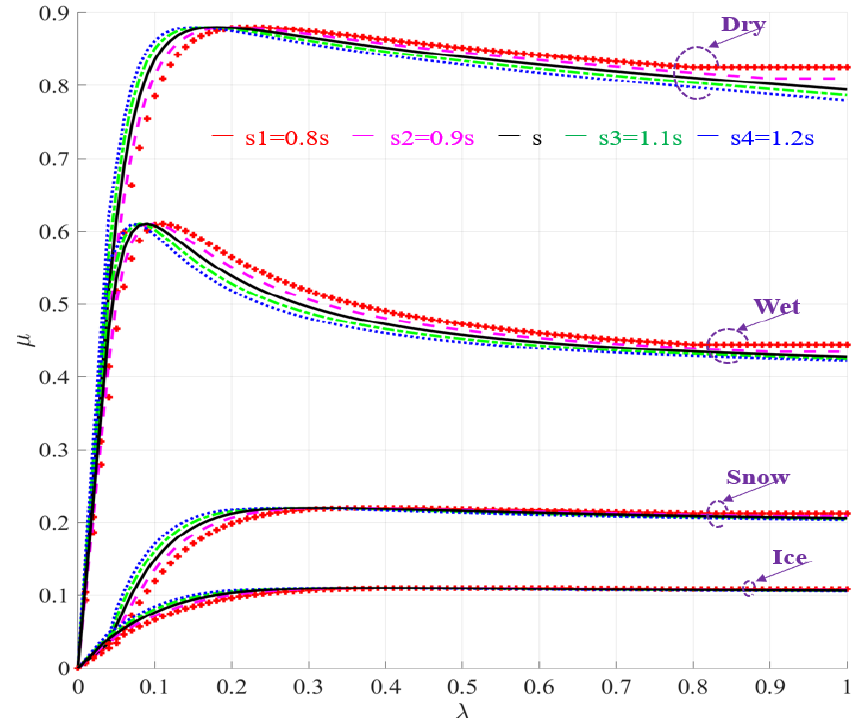
Figure 9. The horizontal change of the curve µ ( λ )